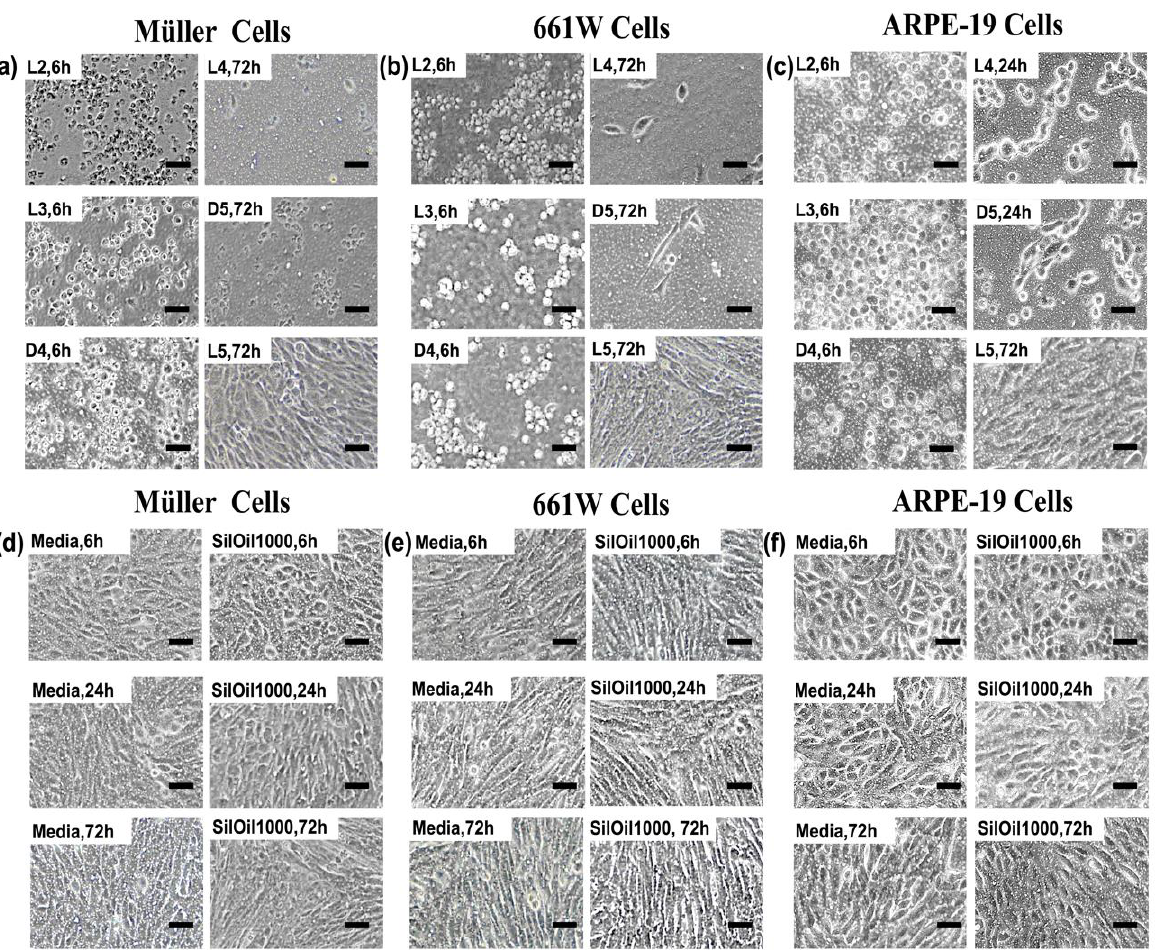
Figure 3. Cell morphology after incubation with liquid LMWCs. Representative images of ( a ) Müller cells (rMC-1); ( b ) photoreceptor cells (661W); and ( c ) retinal pigment epithelial cells (ARPE-19) after incubation with various types of LMWCs at different time points. Morphologies of ( d ) Müller cells (rMC-1), ( e ) photoreceptor cells (661W) and ( f ) retinal pigment epithelial cells (ARPE-19) after incubation with control groups including culture and SilOil 1000 for 6, 24 and 72 h. The results in ( a – f ) are representative of those from 3 independent experiments with 2 replicates each.